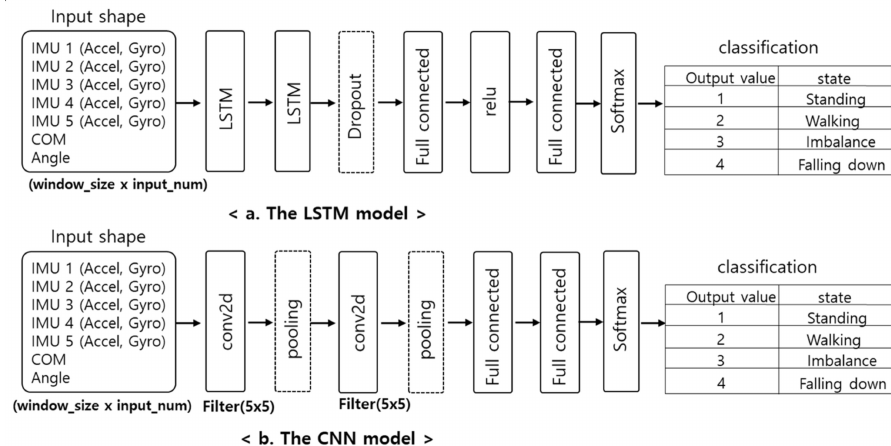
Figure 6. Learning